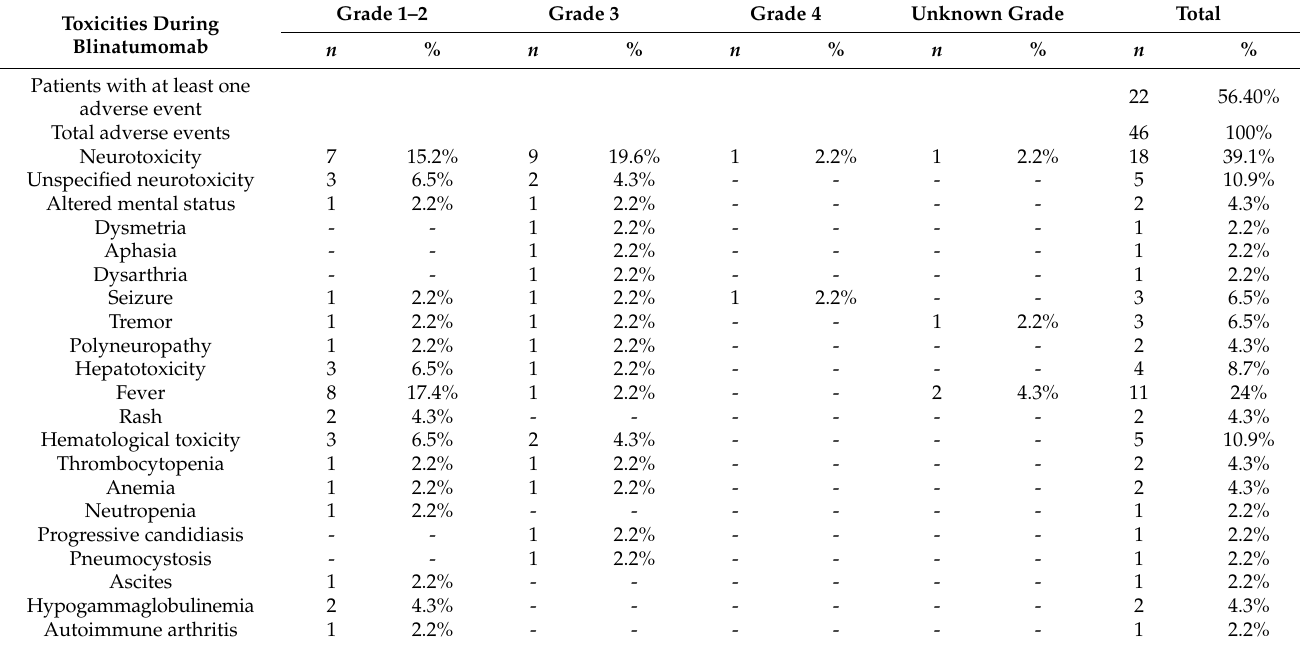
Table 2. Adverse events registered according to the Common Terminology Criteria for Adverse Events (CTCAE v 4.03), number and percentage for each event and